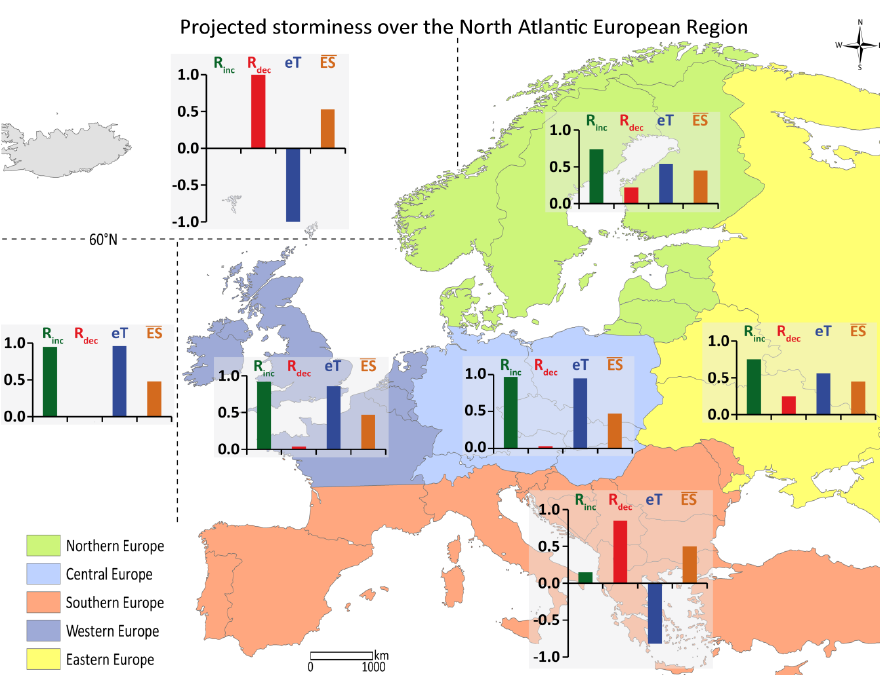
Figure 2. Relative proportions of ratings indicating either increasing ( R inc ) or decreasing ( R dec ) tendencies of aspects of projected future storminess, subregion-related eT -, and 𝐸𝑆 ̅̅̅ -values for the seven subregions of the NAER. The 𝐸𝑆 ̅̅̅ -values were divided by 10 to adapt them to the scaling. The height of the columns corresponds to the numbers given in the subregion-related text sections.